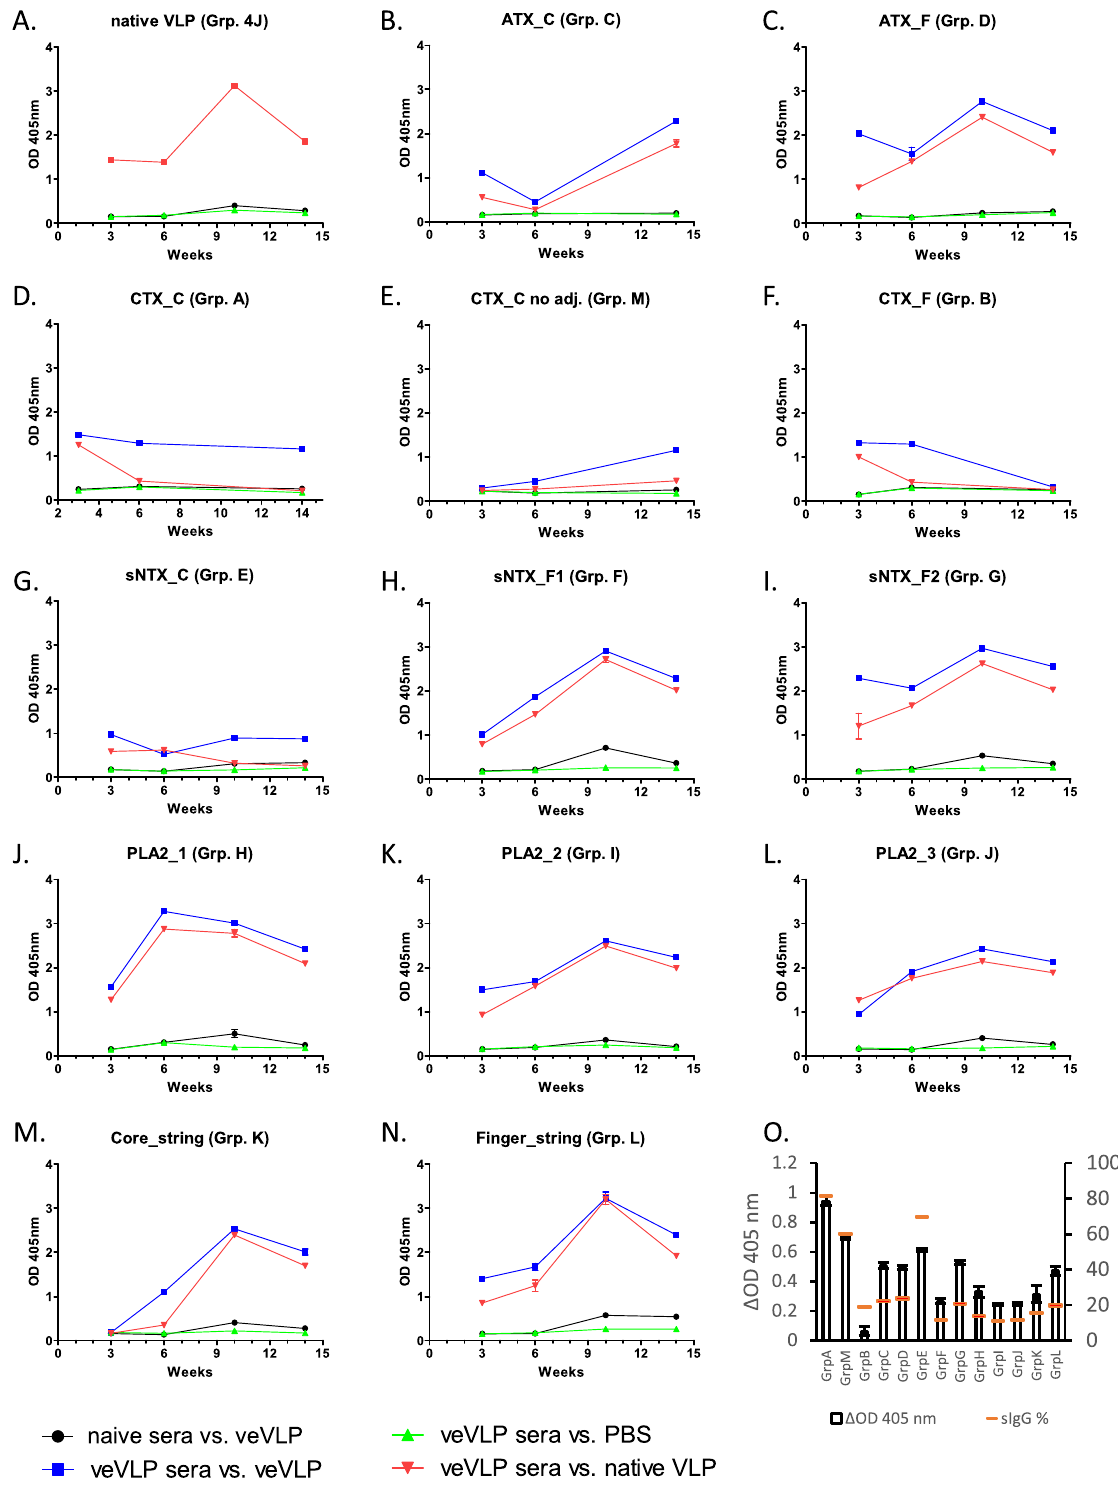
Figure 1. Panels ( A – N ) ELISA time course of antibody responses to immunisation with veVLP antigens. OD 405nm values displayed are signals generated using a 1 in 500 dilution of neat sera pooled from all individuals in that group. ATX Aminergic-type, CTX type 1A cytotoxin, sNTX short chain neurotoxin, PLA2 group I phospholipase A 2 , _ C core located epitope, _ F finger located epitope. Panel ( O ) Demonstration of proportion of pooled group terminal sera at 1 in 500 dilution, in recognising respective specific epitope versus the VLP, displayed as both difference in OD 405 (ΔOD405) between veVLP and native VLP, and as a percentage proportion of the total IgG response (specific IgG [sIgG]). Results represent triplicate readings, with exceptions stated in Supp. File 4. Error bars represent ± standard